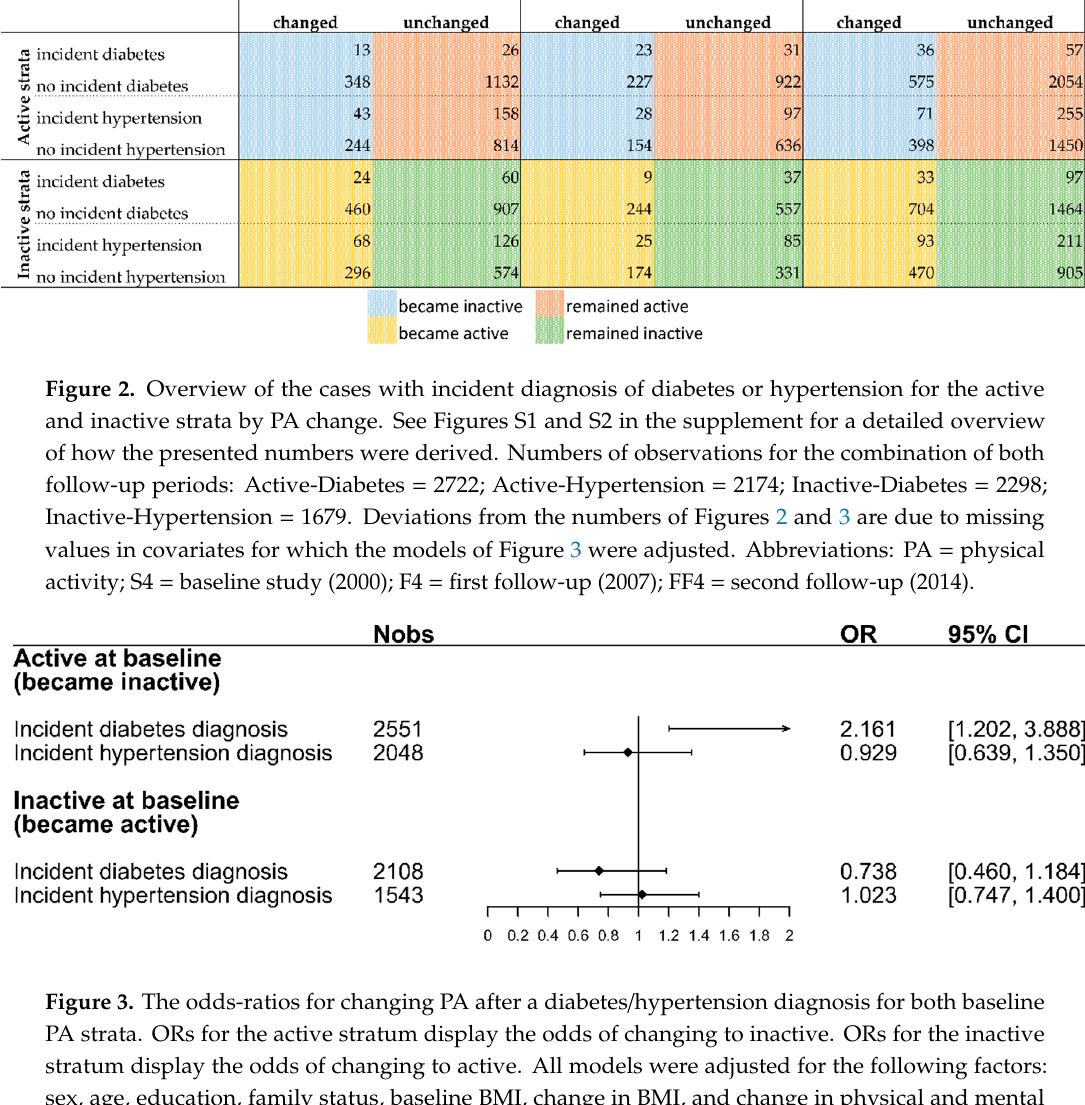
Figure 2. Overview of the cases with incident diagnosis of diabetes or hypertension for the active and inactive strata by PA change. See Figure S1 and Figure S2 in the supplement for a detailed overview of how the presented numbers were derived. Numbers of observations for the combination of both follow-up periods: Active-Diabetes = 2722; Active-Hypertension = 2174; Inactive-Diabetes = 2298; Inactive-Hypertension = 1679. Deviations from the numbers of Figures 2 and Figure 3 are due to missing values in covariates for which the models of Figure 3 were adjusted. Abbreviations: PA = physical activity; S4 = baseline study (2000); F4 = first follow-up (2007); FF4 = second follow-up (2014).